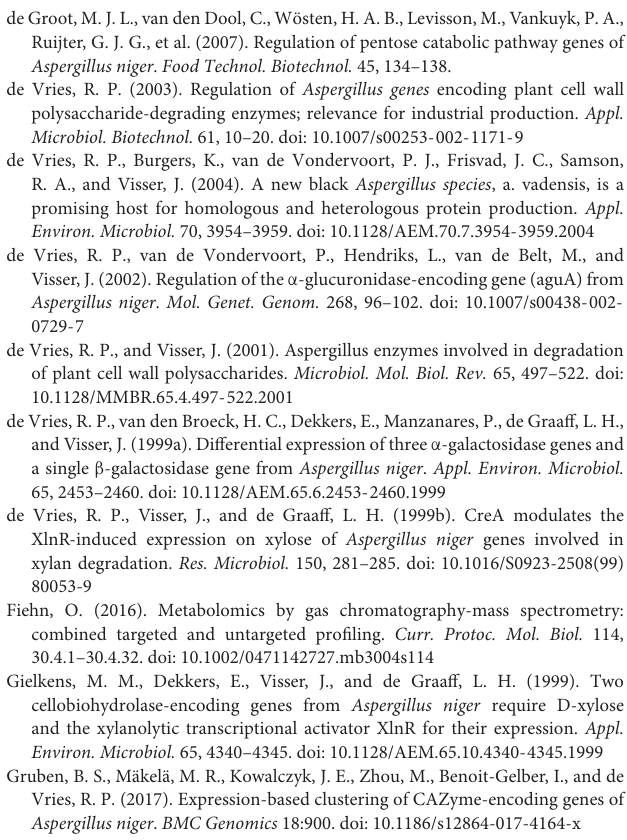
detected for a protein in a sample, a zero value was used. "Inf" values shown in the fold change columns are caused by zero values in the mutant. All values are averages of triplicates. The fold change is the difference between the reference strain and the deletion mutants. Supplementary Table 4 | Expression levels (FPKM) of genes encoding enzymes that are classified in the same Pfam family or show relatively close homology to A. niger pentose reductases and polyol dehydrogenases, during growth on (A) wheat bran (WB) and (B) sugar beet pulp (SBP) in the A. niger reference strain (N593 (cid:49) kusA) and the PCP deletion mutants. Transcripts were considered differentially expressed if the DESeq2 fold change was > 2 (highlighted in